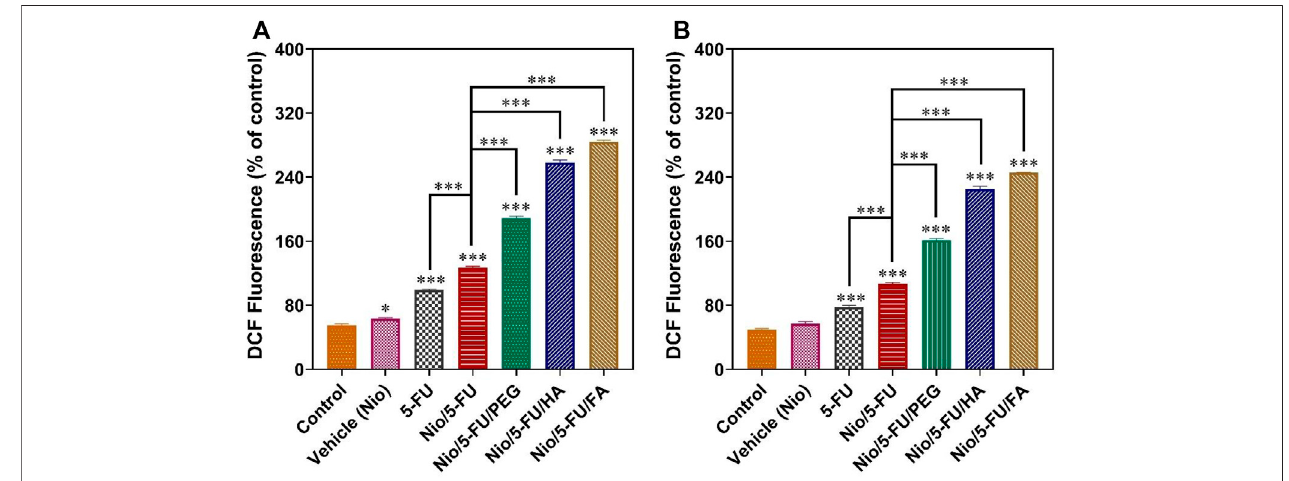
FIGURE 7 | Changes in intracellular ROS content, indicated by the fl uorescence of 2 ′ , 7 ′ -dichlorodihydro fl uorescein (DCF), are summarized in (A) for MCF7 cells and (B) for 4T1 cells. Data represent means ± standard deviations ( n = 3). For all charts, ***: p < 0.001; **: p < 0.01; *: p <